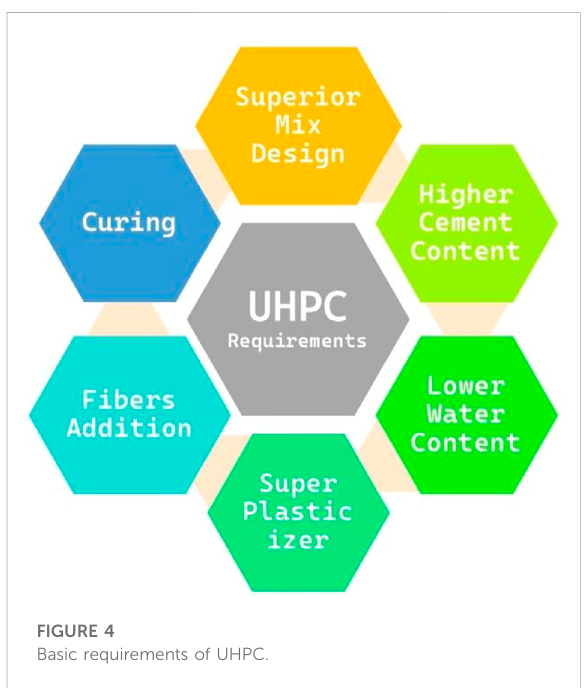
FIGURE 4 Basic requirements of UHPC.